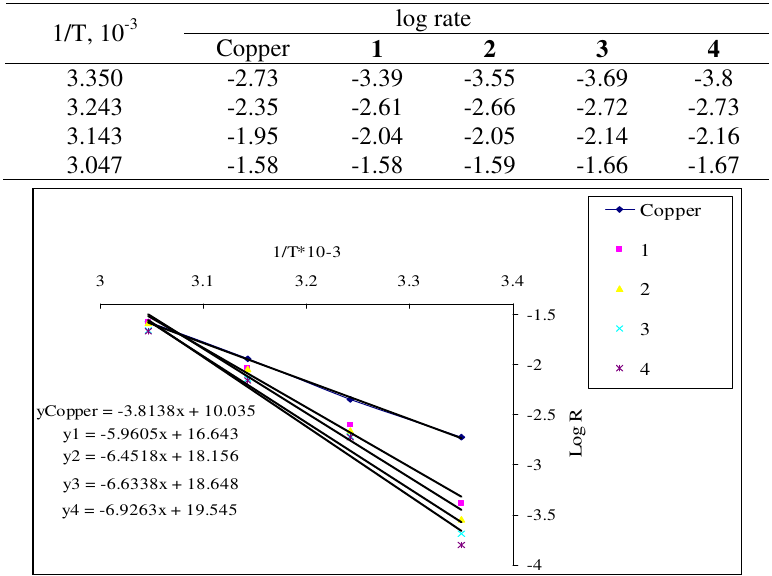
Table 4. Variation of log rate without and with the presence of inhibitors verses reciprocal of temperature